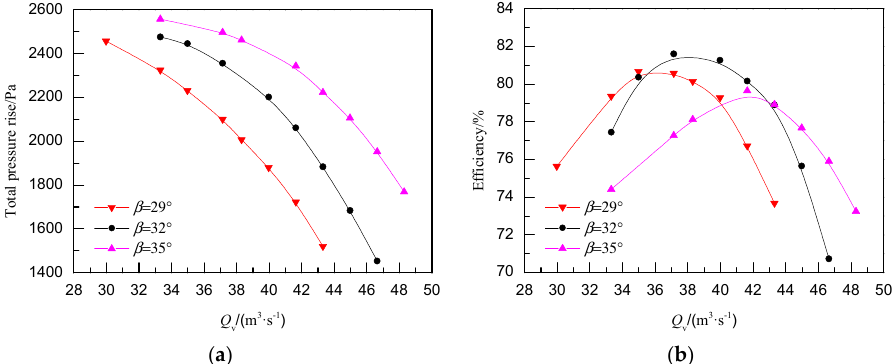
Figure 6. Performance curve of original fan at β = 29 ◦ , 32 ◦ and 35 ◦ . ( a ) total pressure rise; ( b ) e ffi